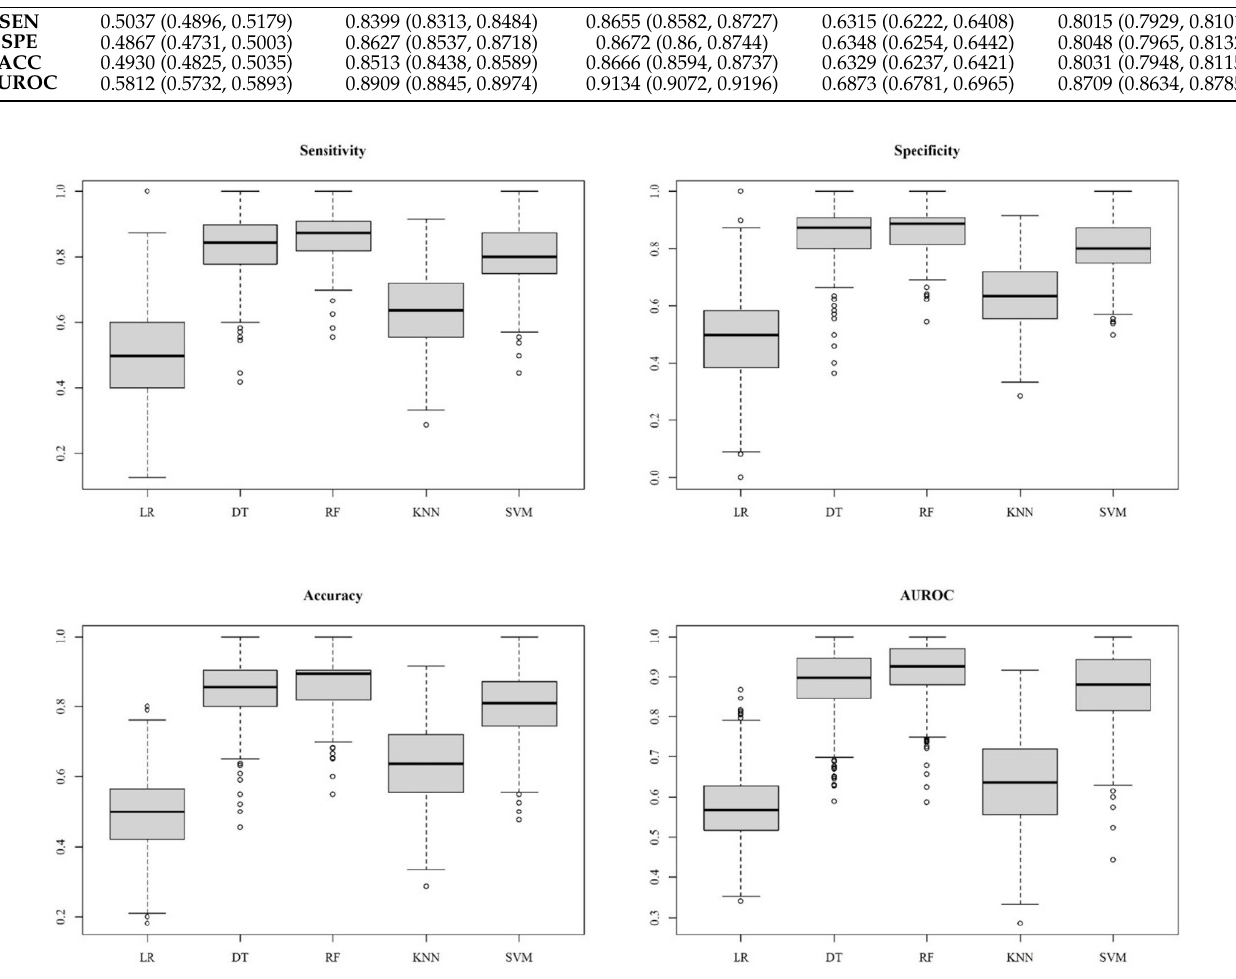
Figure 8. Diagnostic performance of the models by ROC curve. ROC curves of the five predictive models. LR: logistic regression; DT: decision tree; RF: random forest; KNN: k-nearest neighbor; SVM: support vector machine. 3.3. Discriminative Peaks We found 20 informative peaks by the RF importance method (Figure 9A). As Figure 9A shows, we ranked all 20 peaks in the order of Gini index. The Gini index was used to evaluate the importance of a feature in this study. The Gini index calculated the impurity of the training tuples D, and the formula is